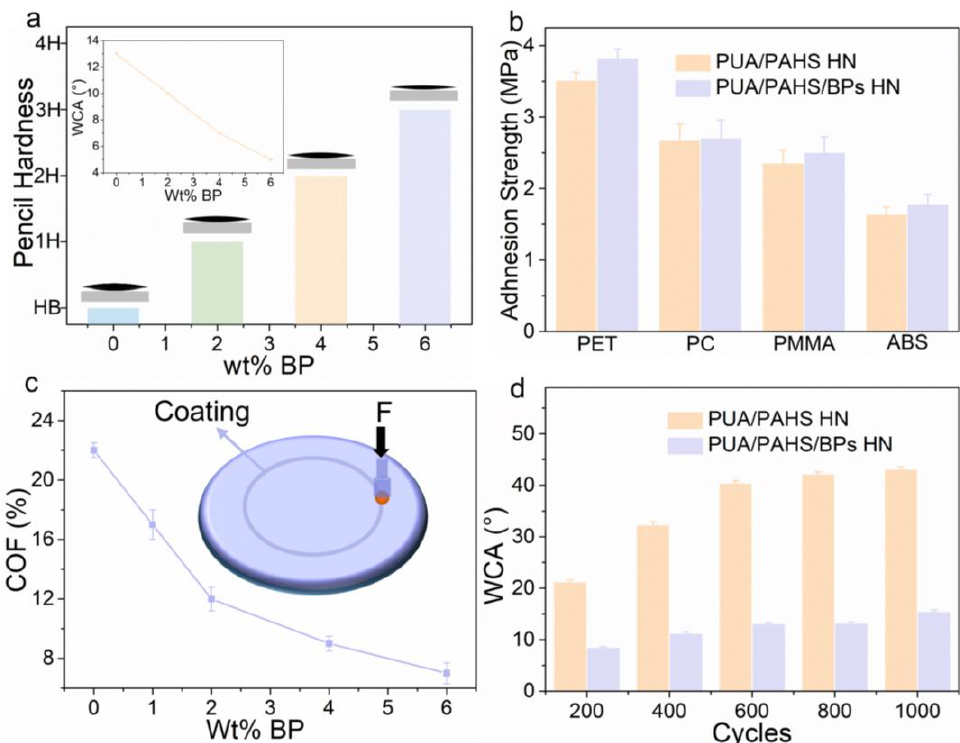
Figure 3. Mechanical properties of BPs hybrid polymer HN coating and nonhybrid polymer HN coating. ( a ) Pencil hardness of PUA/PAHS/BPs HN with different BPs content. Inset: WCA of PUA/PAHS/BPs HN with different BPs content. ( b ) Adhesion strength of PUA/PAHS/BPs HN and PUA/PAHS on PET, PC, PMMA and PBS substrates. ( c ) Coefficient of friction (COF) curve of PUA/PAHS/BPs HN with different BPs content. Inset: schematic diagram of ball disc friction tests. ( d ) WCA of the PUA/PAHS/BPs HN and PUA/PAHS HN under different friction cycle tests.